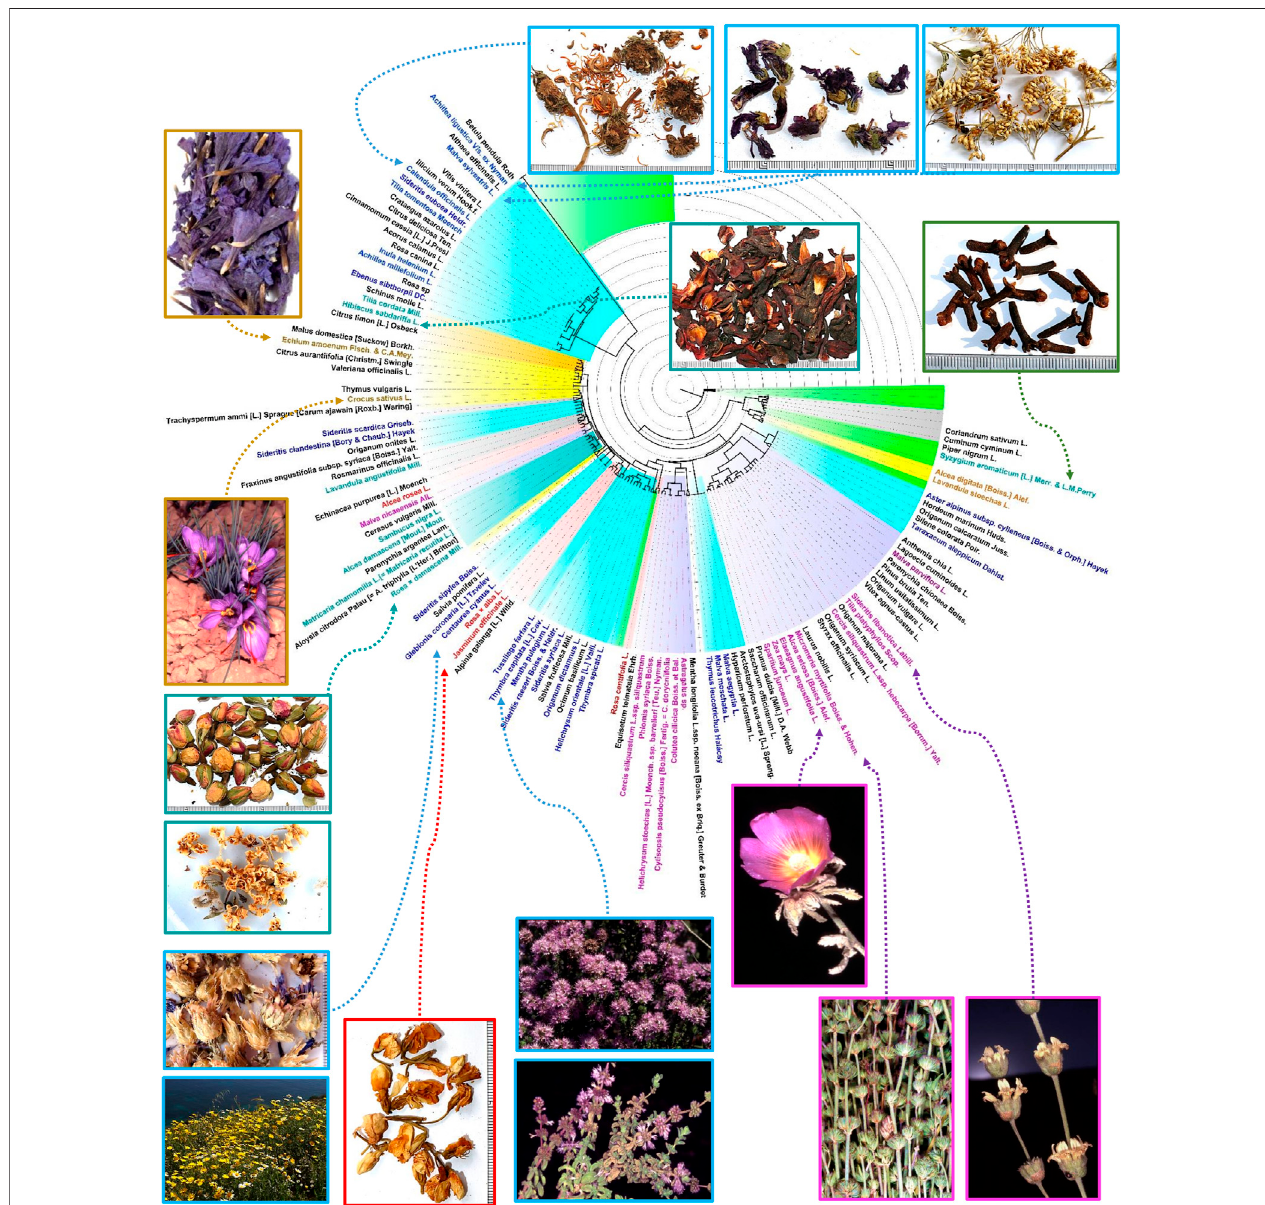
FIGURE 5 | Ward ’ s minimum variance tree with clusters displaying the association between species. Note: Branches fully composed of non- fl oral ingredients appearcollapsedinthetree.Colorcodesbasedinthecorrelationofspecieswiththeirgeographicalprovenance:Blue,Greeksamples;Magenta, “ Zhourat ” ;Red,Turkish samples; Yellow and golden, Iranian samples; Green, Arabian style spices mixtures; Olive, species appearing in the different geographical groups. Black, species furnishing non fl oral ingredients. Images: C. Obón and D. Rivera.